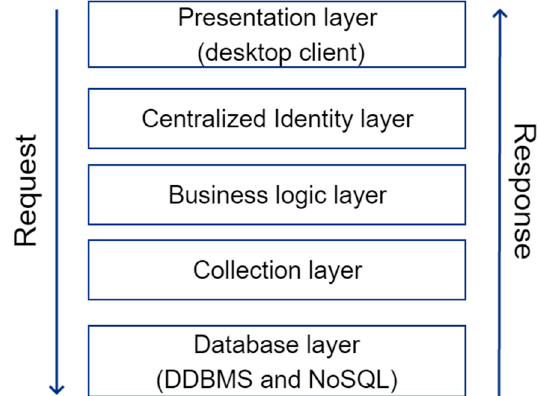
Figure 1. VoRtex high-level layer-based architecture.